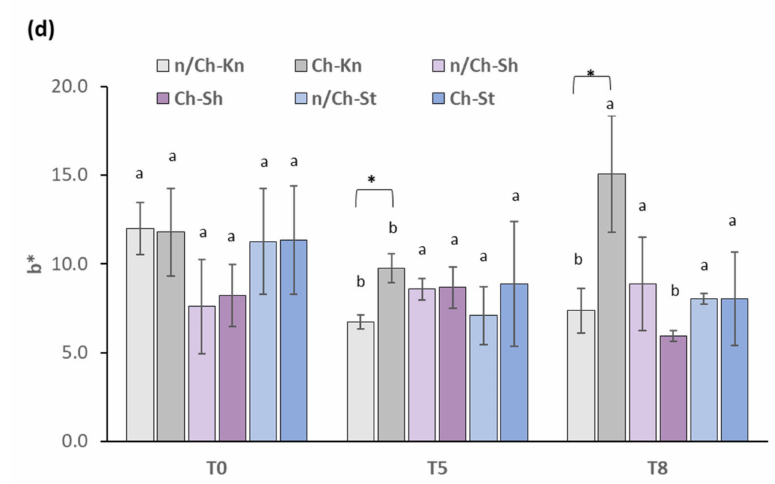
Figure 4. Color properties—( a ) ∆ E*, ( b ) L*, ( c ) a* and ( d ) b*—of vacuum-packed non-coated and coated beef cut samples over the storage period of 0 (T0), 5 (T5) and 8 (T8) days at 4 ◦ C. n/Ch–Sh = non-coated shoulder; Ch–Sh = coated shoulder; n/Ch–St = non-coated striploin; Ch–St = coated striploin; n/Ch–Kn = non-coated knuckle; Ch–Kn = coated knuckle. Columns represent the mean ( n = 3), and the bars represent the SD. a,b Different letters indicate significant differences ( p < 0.05) for the same beef cut sample and with the same treatment over the storage period (T0, T5 and T8). * Significant differences ( p < 0.05) between the same beef cut with different treatments (non-coated and coated samples) on the same storage day.